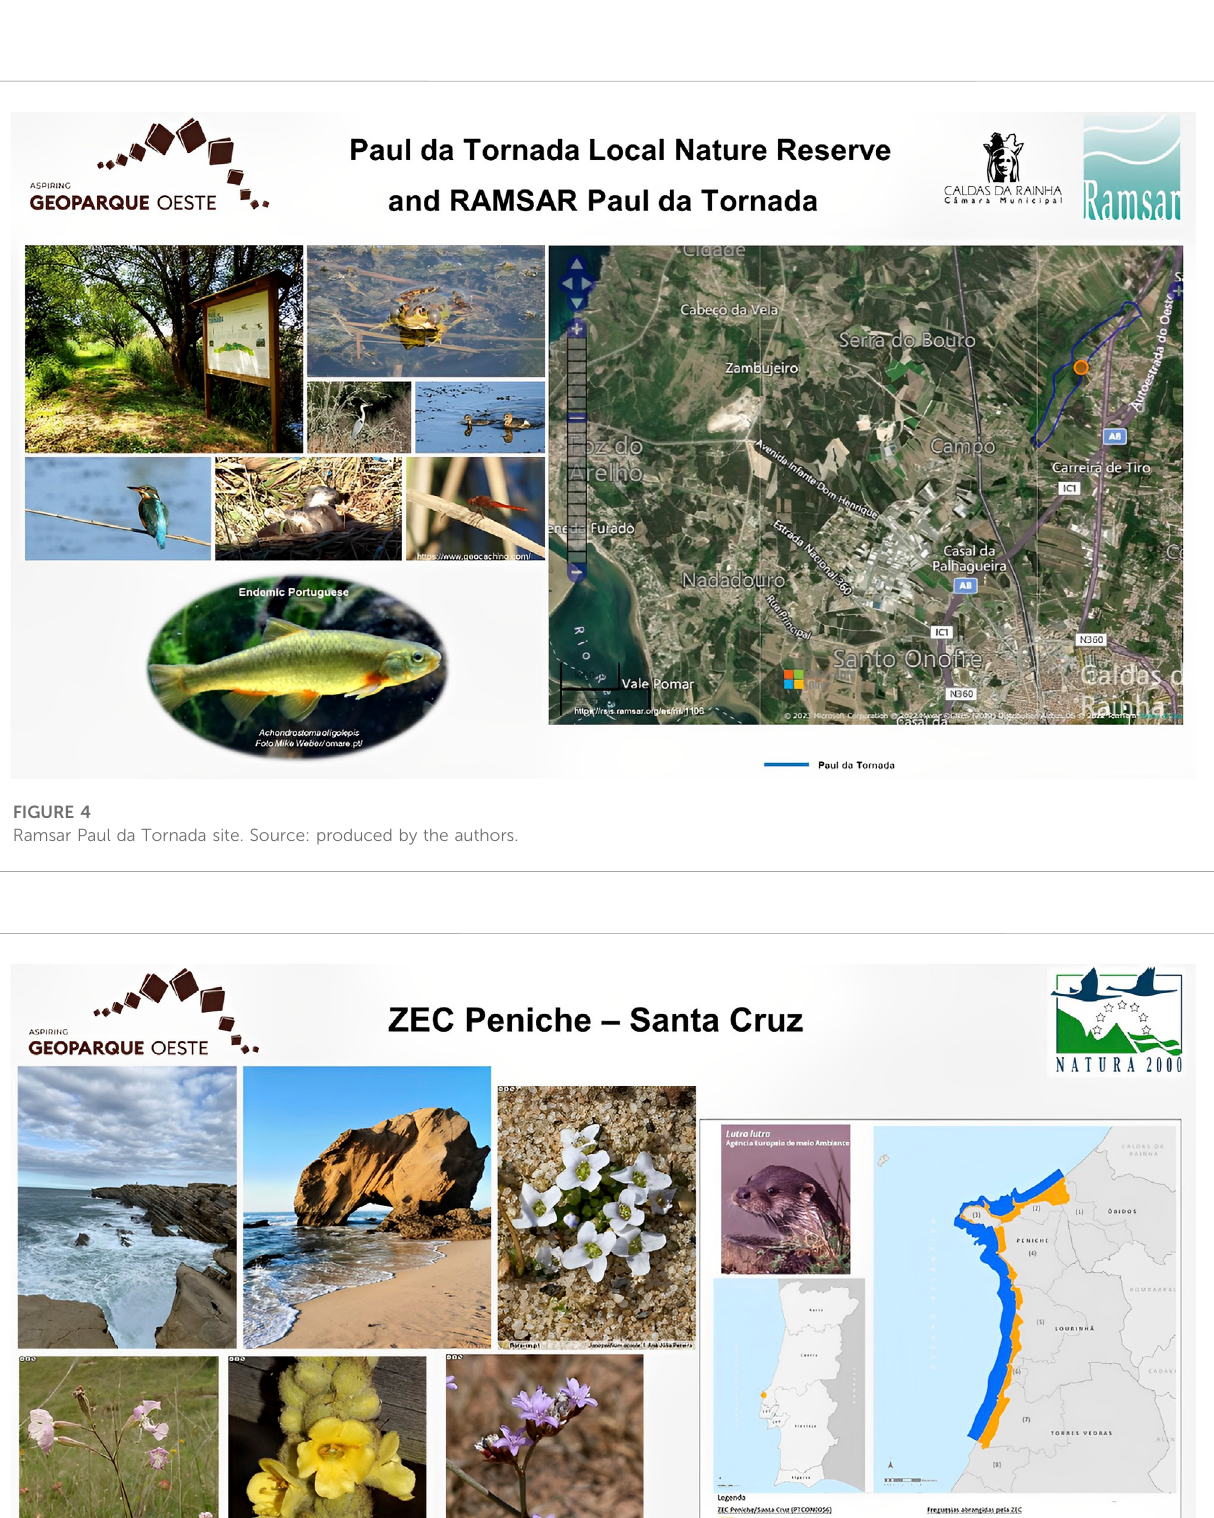
Frontiers in Environmental